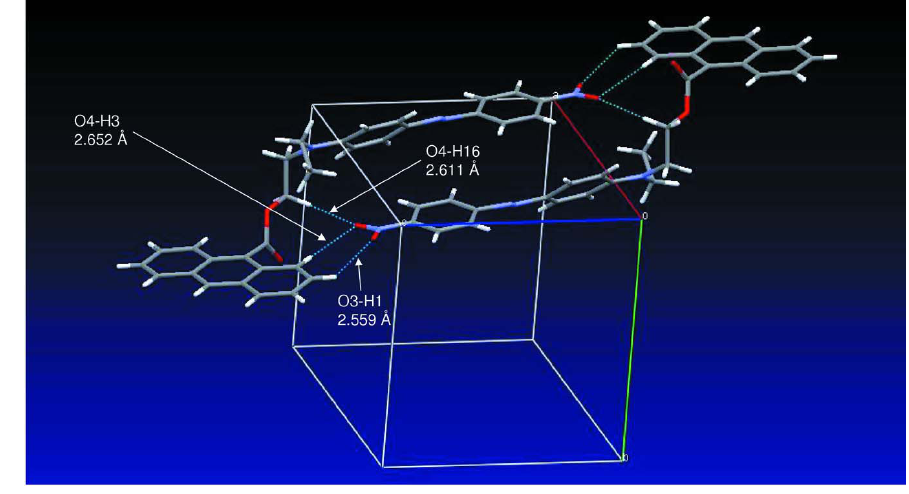
Figure 2 Packing of (I) as viewed down the a axis illustrating weak C—H···O hydrogen bonding associated with terminal O atoms O3 and O4. The nitroasobenzene portion of (I) resides near the a-c plane of the unit